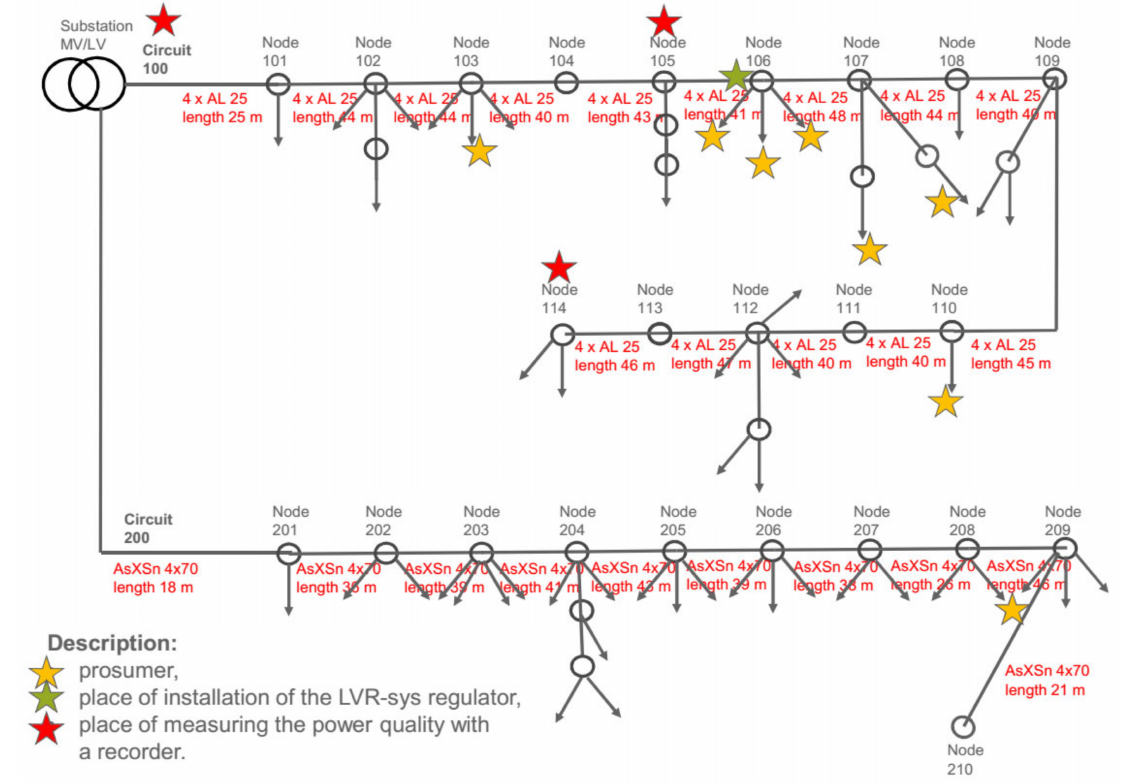
Figure 2. Structure of the analyzed low-voltage network for circuits ‘100’ and ‘200,’ as well as information about the location of the photovoltaic sources, the places where the measurements were made with a recorder, and the node where the LVR-sys is